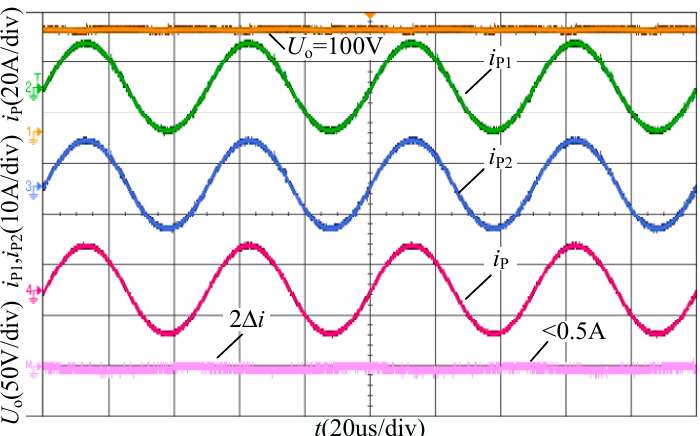
Δ ∆ i with the current phasor control. with the current phasor control. Figure 11. The waveforms of U o , i P1 , i P2 , i P and 2